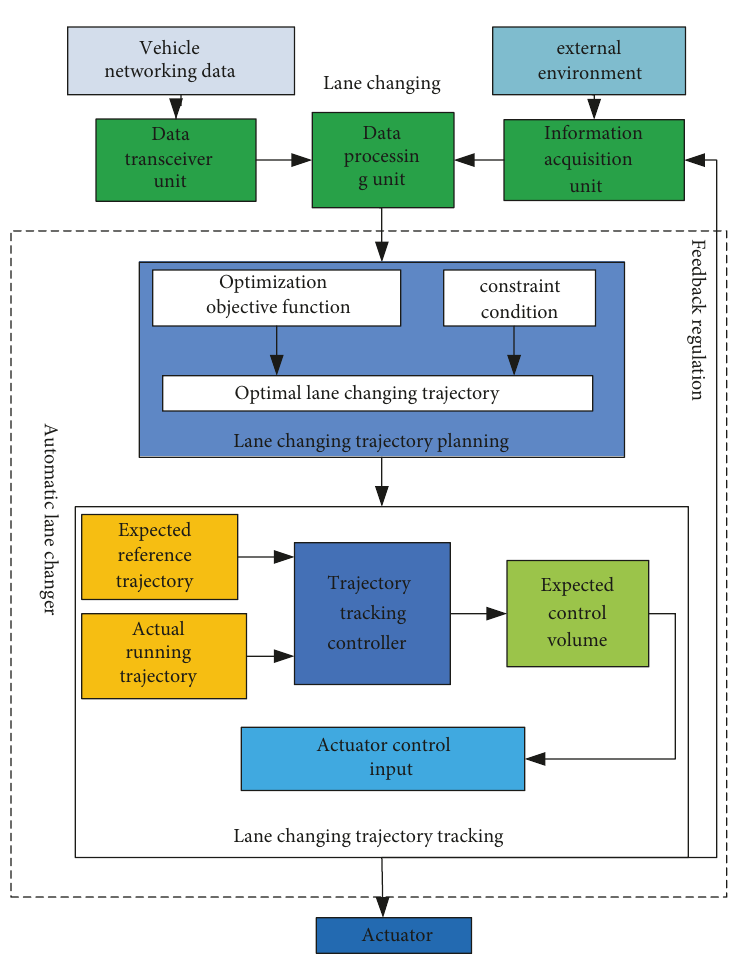
Figure 1: THE flow chart of automatic change of track under the condition of vehicle interconnection.